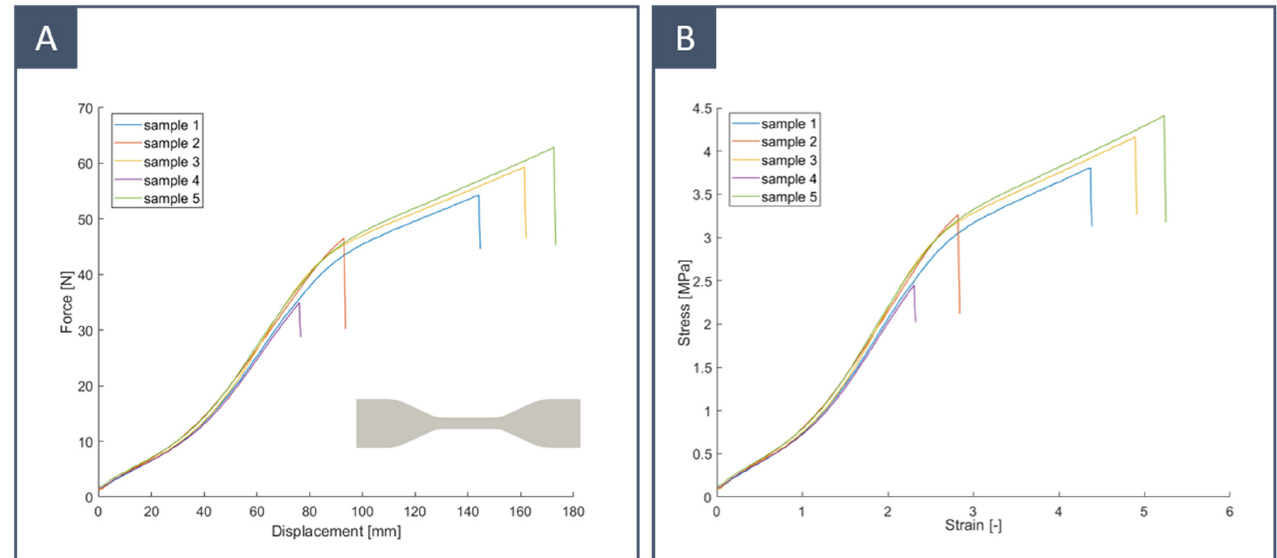
Figure 9. Uniaxial tests for five dog bone samples of silicone rubber KE-1603-A: ( A ) force–displacement curve; ( B ) stress–strain curve. Table 4. Average mechanical data from in vitro studies on CA specimens evaluated by uniaxial strain/stress measurements [37].